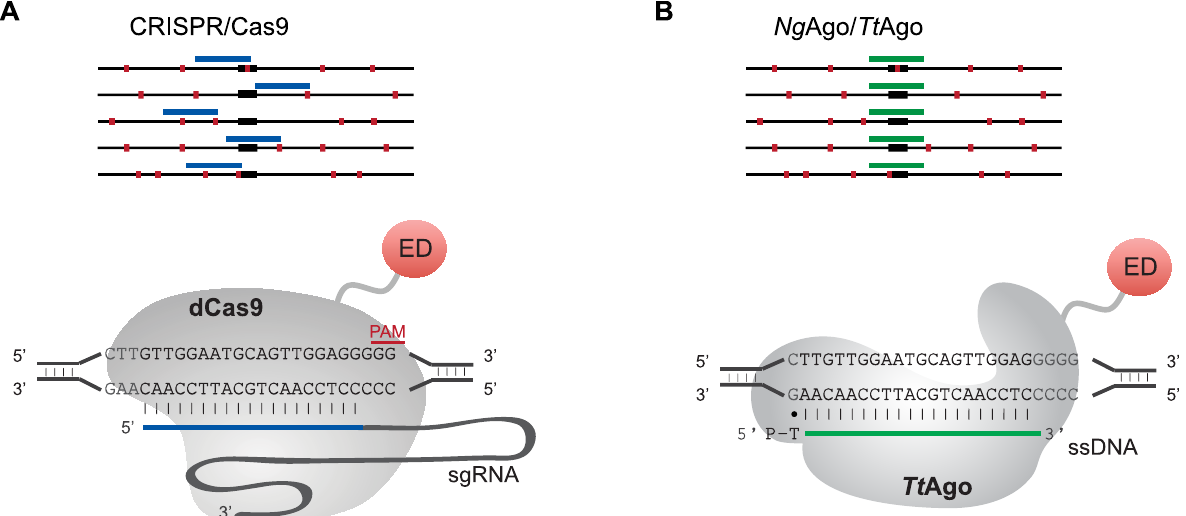
Fig 1. The potential for high-precision targeting by pAgos. A. Targeting of CRISPR/Cas9 is limited by the requirement of a PAM site (green boxes). B. Ng Ago or Tt Ago might allow the precise targeting of features, such as transcription factor binding sites (black boxes). gRNA/gDNA, red